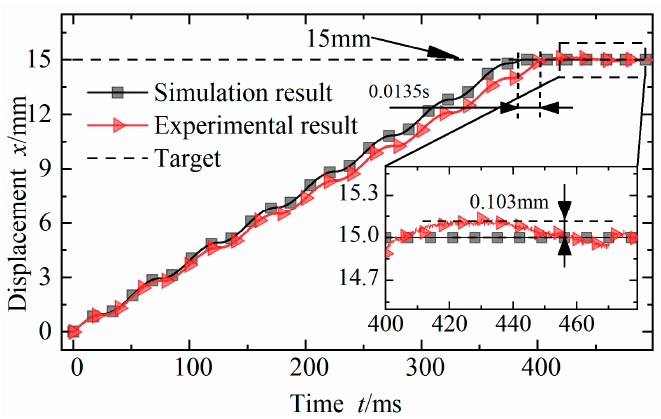
Figure 11. Response curve of step target.